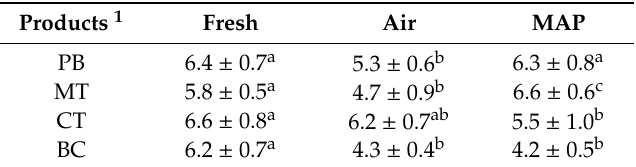
Table 8. Liking scores carried out by consumer test at day 0 (fresh) and after 7 days of storage in air and MAP followed by MW heating. Values in the same row with di ff erent letters are significantly di ff erent (Tukey’s LSD, p <